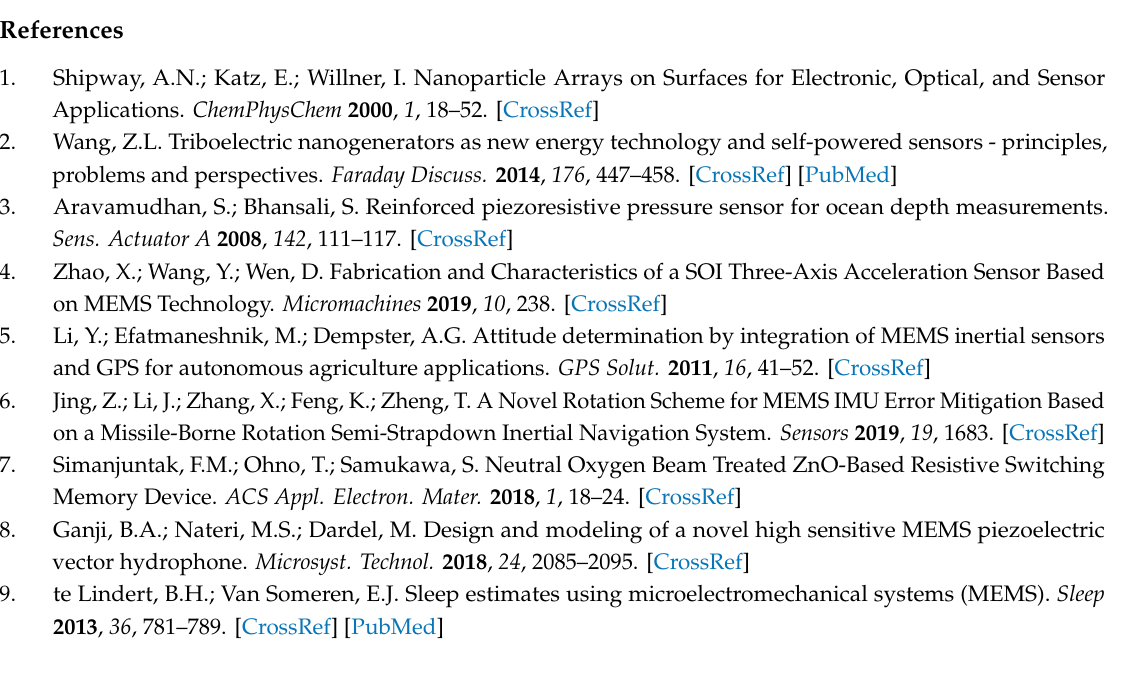
Figure 15. Sensitivity of the sensor in the range from 1355 Hz to 1363 Hz.